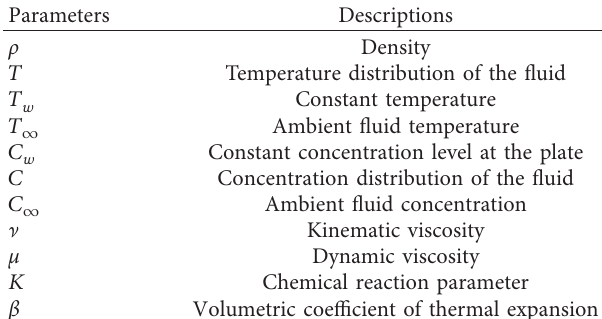
Table 1: Nomenclature section.